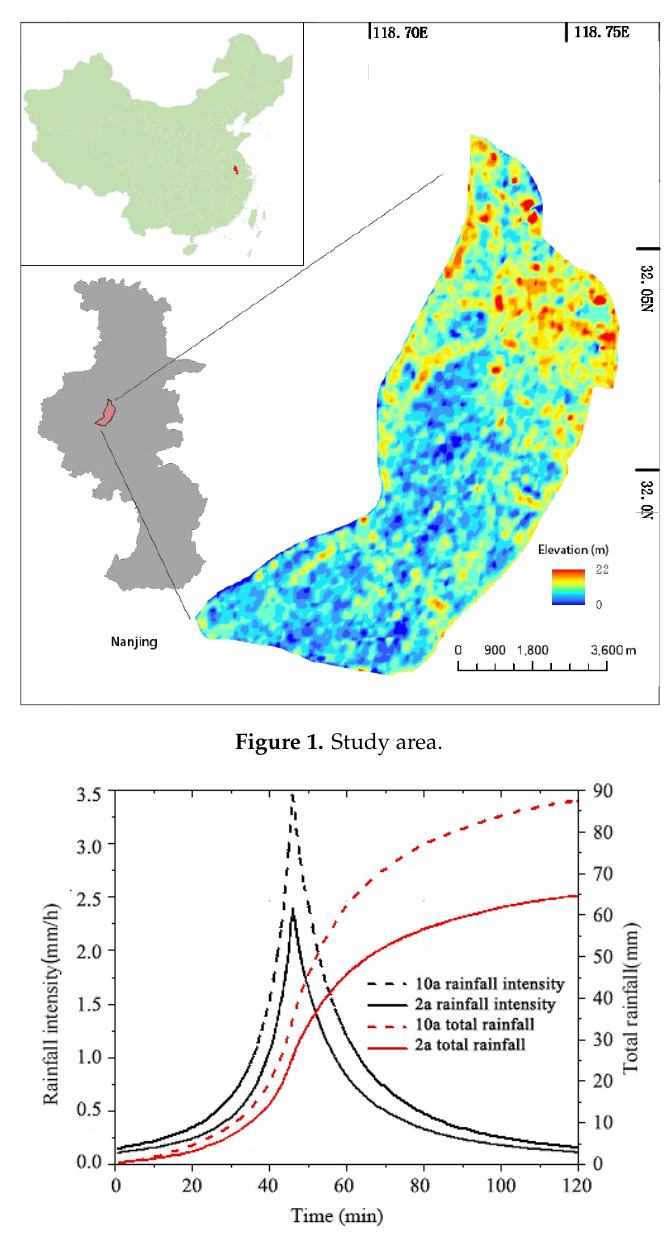
Figure 2. The 2 and 10 year rainfall intensities and total rainfall.